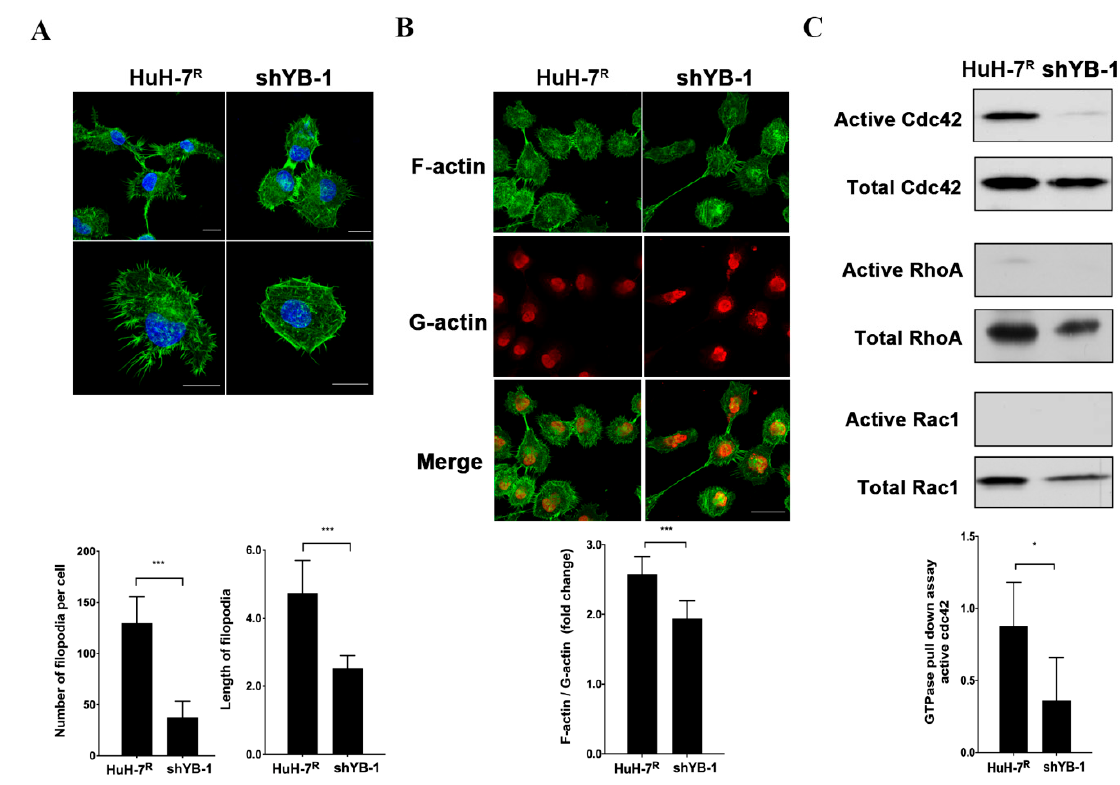
Figure 6. YB-1 regulates filopodia formation through modulating Rho GTPases activity and reorganization of the actin cytoskeleton in HuH-7 R cells. ( A ) YB-1 knockdown induced filopodia regression. F-actin was stained with phalloidin- conjugated Alexa Fluor 488 (green). DNA was counterstained with DAPI (blue). The number and length of filopodia per cell were calculated from 20 cells in each group (*** p < 0.001, Scale bars = 20 μ m). ( B ) G-actin and F-actin were visualized via immunofluorescence staining with Alexa Fluor 488 phalloidin (F-actin, green) and DNase I-conjugated Alexa Fluor 594 (G-actin, red). The F-actin to G-actin ratio per cell was calculated from 50 cells in each group (*** p < 0.001, Scale bar = 50 μ m). ( C ) Rho-family-GTPase activity was examined using a small GTPase family pull-down assay. Total cell lysates were immunoprecipitated and analyzed by immunoblotting with specific antibodies. Active cdc42 was quantified and normalized to total cdc42. Error bars indicate mean ± SEM, and p values were calculated with the t test (* p < 0.05).